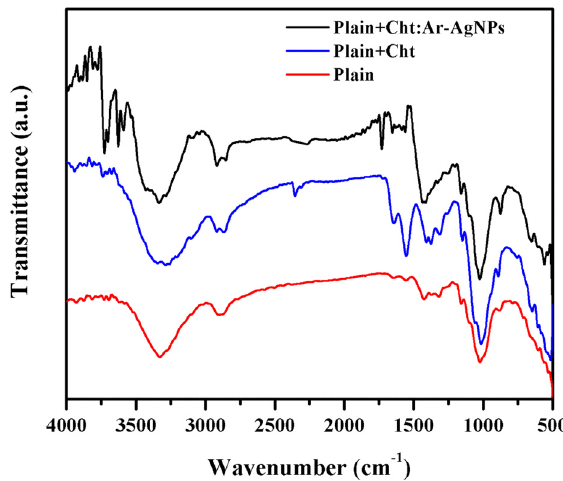
Figure 5: FTIR spectra of plain paper, chitosan - coated paper, and chitosan with agar - mediated AgNPs - coated paper.